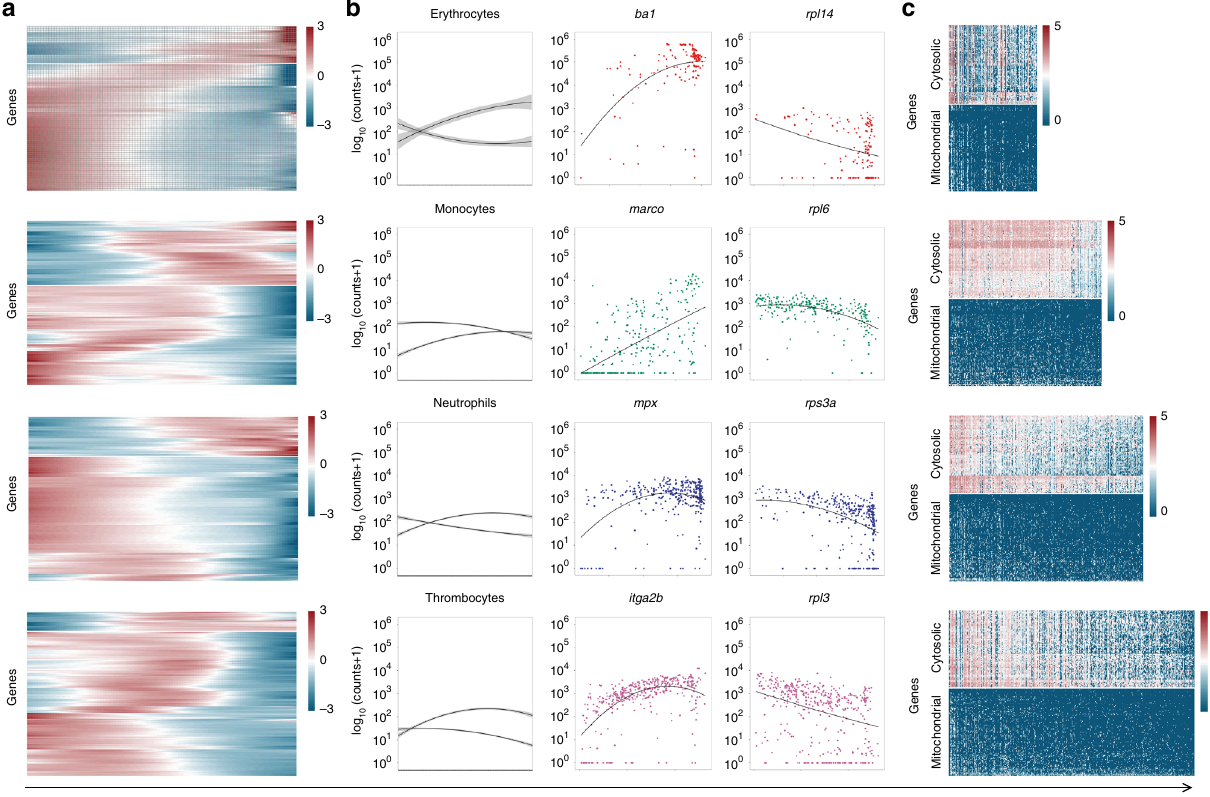
Fig. 5 Lineage differentiation is de fi ned by two main trends in gene expression. a Heatmap of genes whose expression changed dynamically during pseudotime in each of the four branches. b Graph showing the average expression pattern of the dynamically expressed genes that follow the same trend across pseudotime. For each of the cell states, one gene is presented that follows one of the two main trends. Standard error is shown as a grey area around the trend lines. c Heatmap of expression of 168 genes annotated as 'ribosomal proteins' genes in pseudotime in each of the four